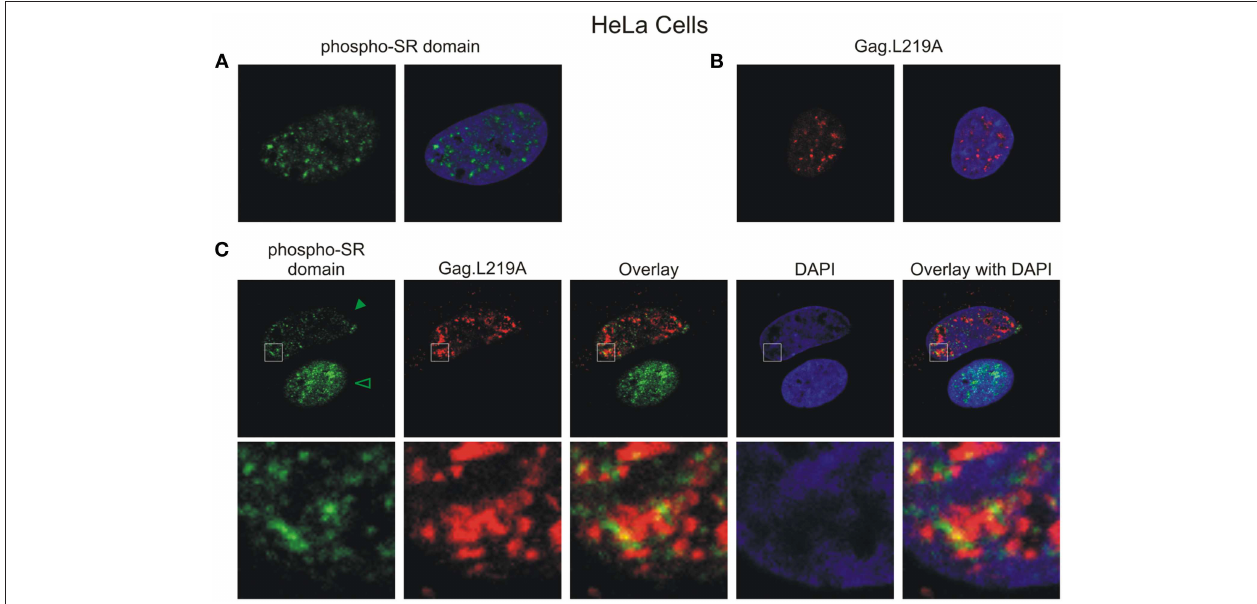
FIGURE 4 | Gag.L219A localization with endogenous splicing speckles in HeLa cells. (A) Visualization of endogenous splicing speckles in HeLa cells using immunofluorescence with α -phospho RS antibody (also called α -SC35 antibody; see Materials and Methods). (B) Localization of Gag.L219A in unstained HeLa cells fixed and permeabilized using the conditions outlined in Materials and Methods used to visualize endogenous splicing speckles. (C) Gag.L219A transfected HeLa cells were stained with α -phospho RS antibody. The Gag.L219A and α -phospho RS channels were combined (Overlay). This merged image was overlaid with the DAPI channel (Overlay with DAPI). The same region from each channel denoted by the white box was cropped, enlarged, and displayed in the bottom panel. The intensity of α -phospho RS antibody decreased in the presence of Gag.L219A (indicated by solid arrowhead) compared to cells in which Gag.L219A was not expressed (indicated by open arrowhead) ( p < 0 . 001 ; 6 cells were analyzed per